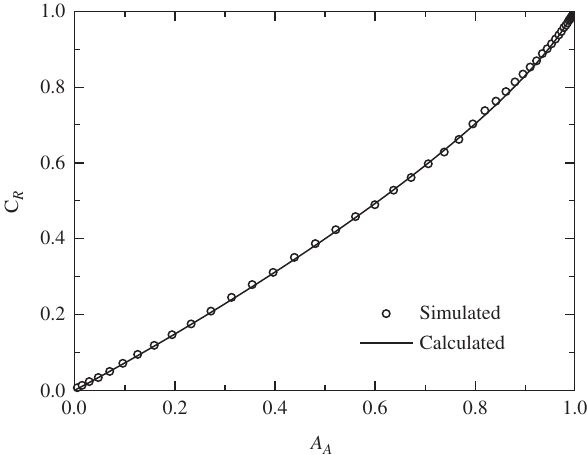
Figure 7. Contiguity, C , against area fraction. Simulation results are in R agreement with those calculated from the kinetics of a single grain, Equa- tion 24. The contiguity is the ratio of immobile interface length to the total interface length.